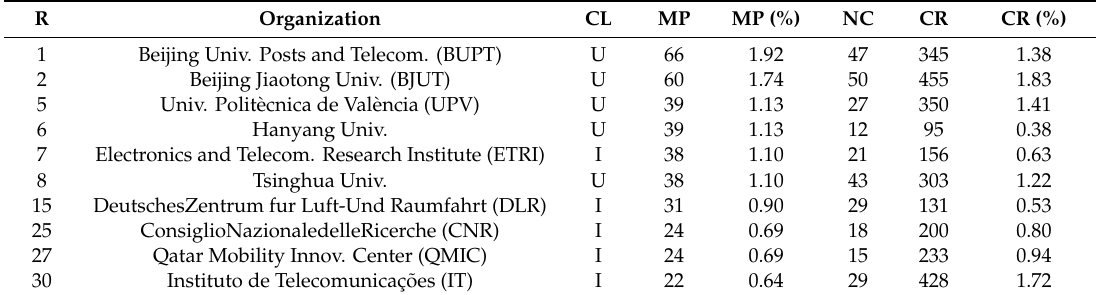
Table 2. Most productive institutions in I2X, V2X, and P2X research from 1996 to 2018.